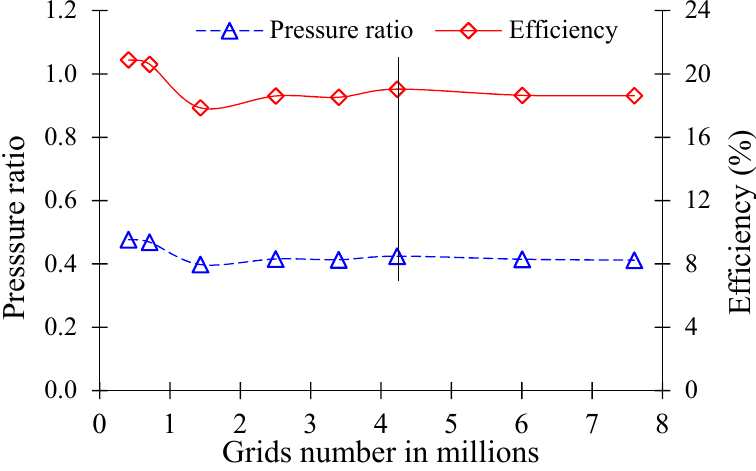
Figure 8. Grid dependency test for AJP model. Table 5. Grid dependency test for SCP CFD analysis via GCI method.